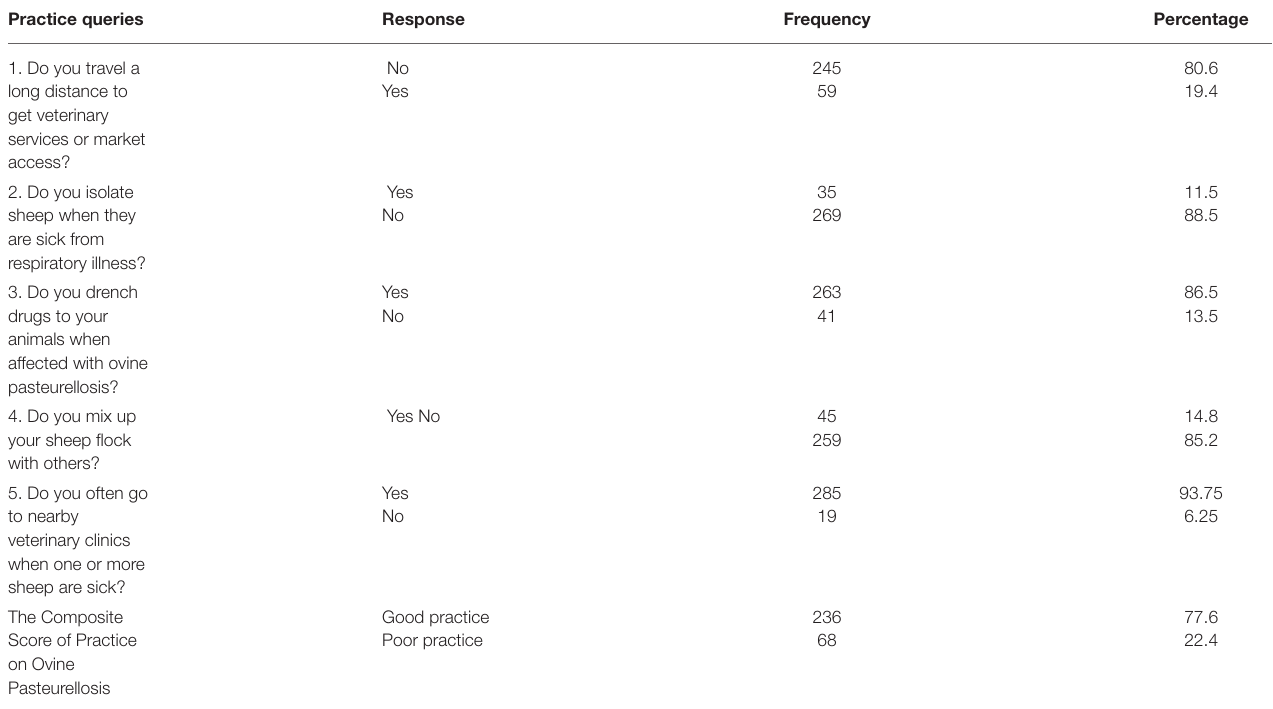
TABLE 3 | Practices of respondents relevant to ovine pasteurellosis ( n =